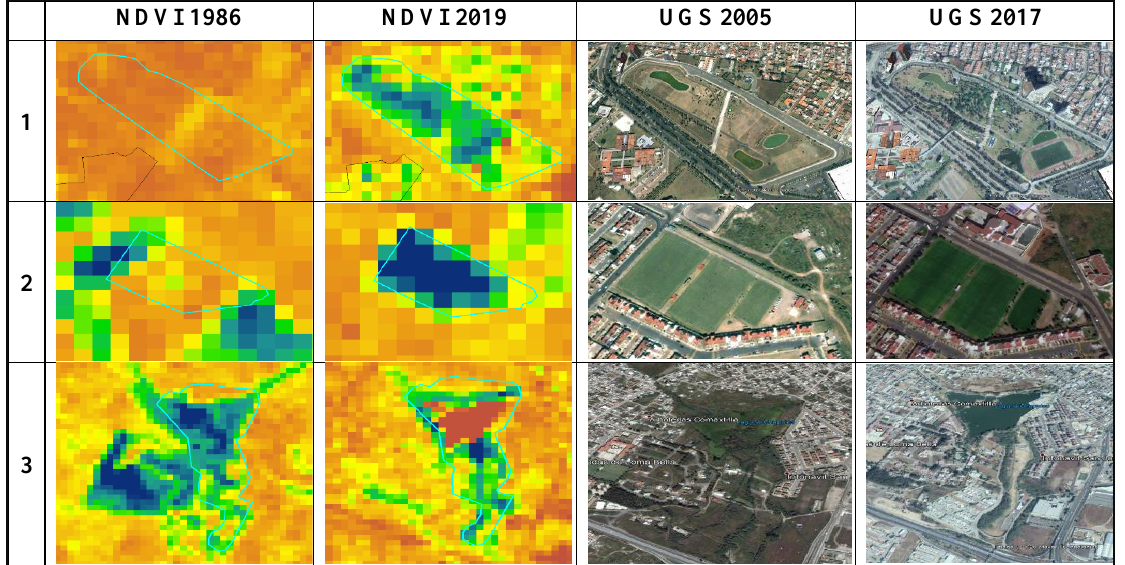
Figure 11. A visual comparison of NDVI in 1986 with 2019 and Google high-resolution images of 2005 and 2017 in which (1) is Jardin del Arte Park (#7), (2) is the soccer field (#71), and (3) is El Centenario/Chapulco Lake Park (#3). All figures face north.